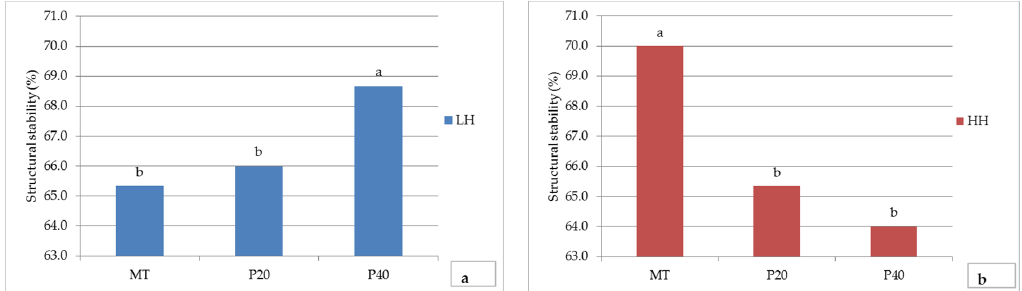
Figure 4. Structural stability of soil aggregates related: ( a ) to low water content treatments LH (58% FC) and ( b ) to high water content treatments HH (80% FC). Average of 18 values.